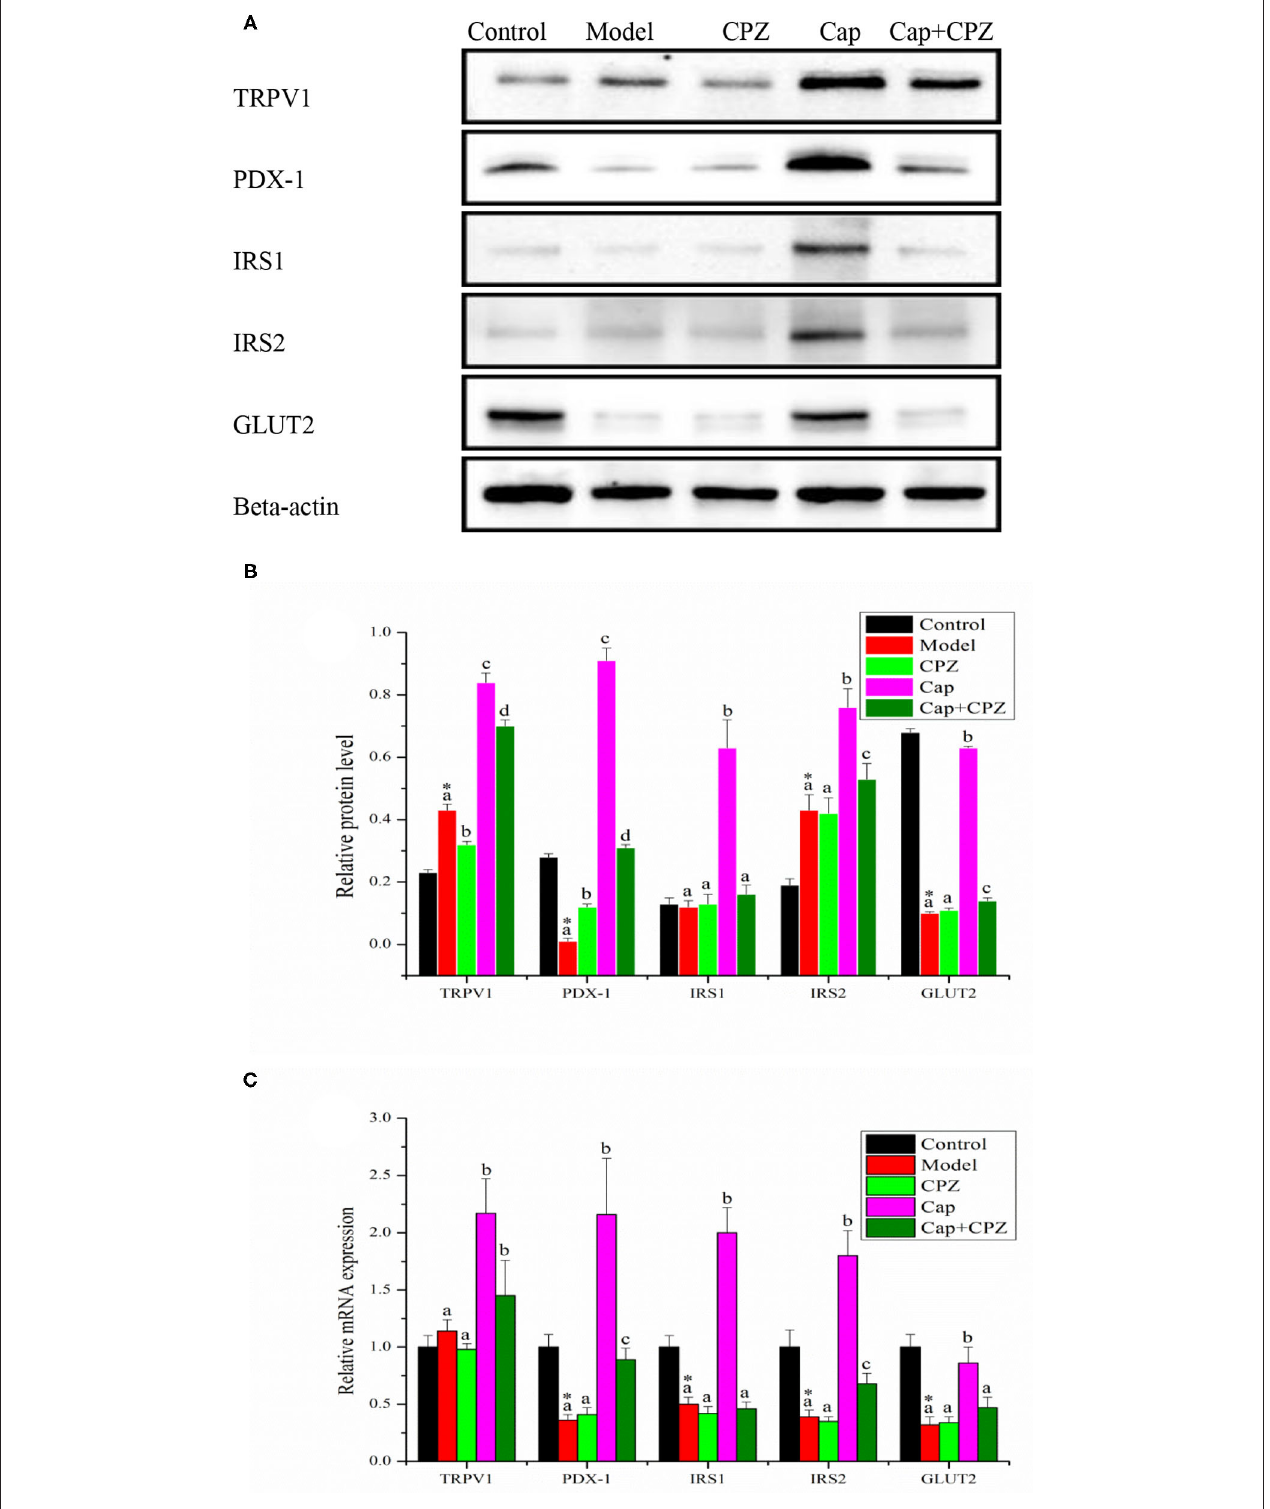
FIGURE 5 | Effects of TRPV1 receptor antagonist and capsaicin on protein (A,B) and mRNA (C) expression levels of key genes for glycometabolism in pancreas of STZ-induced diabetic rats. All data are expressed as means ± SD, n = 8. *Means are significant difference compared with the control group ( P < 0.05). Means with different superscript letters are significantly different among the diabetes groups ( P < 0.05). TRPV1, transient receptor potential cation channel subfamily V member 1; PDX-1, pancreatic duodenal homeobox-1; IRS1, insulin receptor substrate 1; IRS2, insulin receptor substrate 2; GLUT2, glucose transporter 2. Effective concentrations of capsaicin and capsazepine are 6 and 10 mg/kg · BW, respectively.